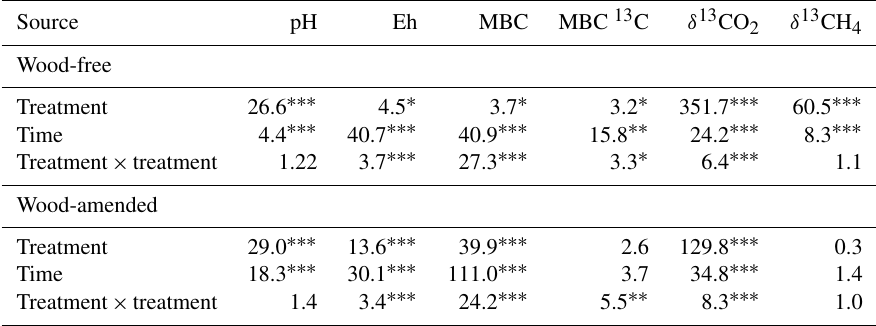
Table 3. Results ( F values and significance) from the repeated-measures ANOVA of pH, Eh, microbial biomass C (MBC), δ 13 C isotopic signature of MBC, δ 13 CO 2 , and δ 13 CH 4 measured in soils collected from a coastal freshwater forested wetland and incubated in the labora- tory for 98d under fully saturated conditions with either freshwater or saltwater (2.5 and 5.0ppt). Data from wood-free and wood-amended soils were analyzed separately.